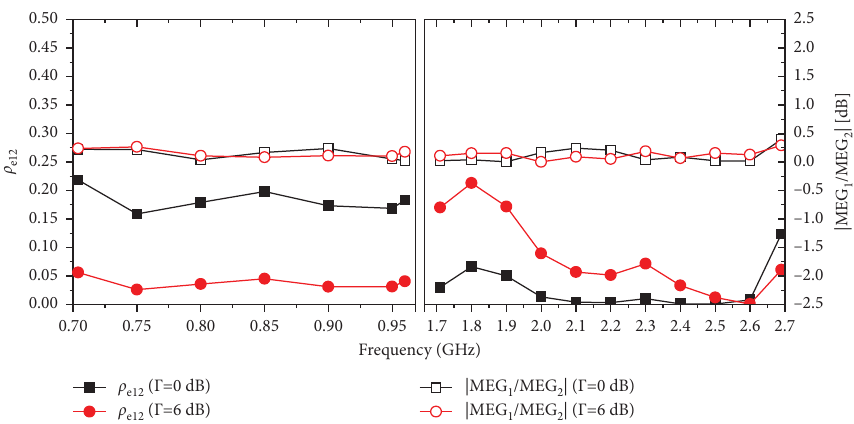
Figure 13: Measured envelop correlation coefficients and mean effective gain of the proposed dual-antenna system.